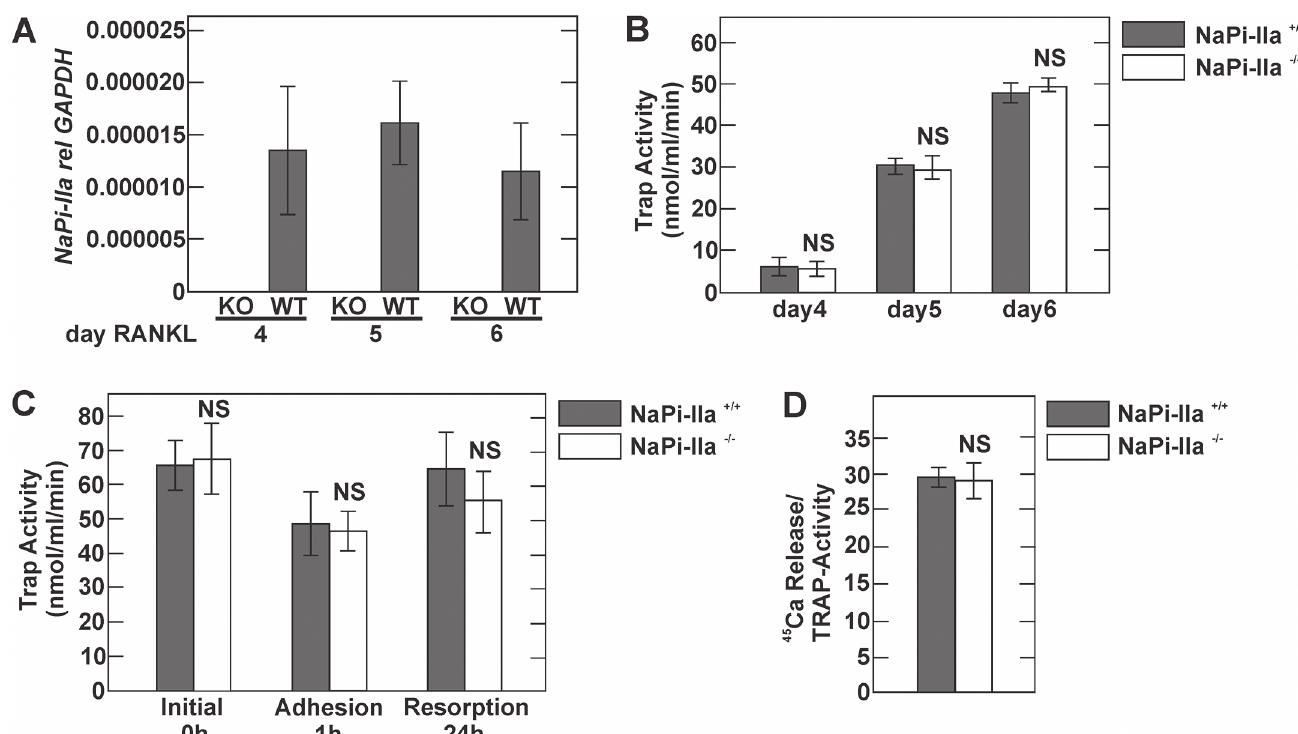
Fig 5. In vitro characterization of NaPi-IIa deficient-osteoclasts. BMMs isolated from NaPi-IIa WT and KO mice were cultured with RANKL for 4, 5 or 6 days. A) NaPi-IIa transcript expression assessed by real-time PCR analysis at days 4, 5 or 6 of RANKL stimulation. Note the absence of NaPi-IIa transcript in osteoclasts derived from NaPi-IIa KO mice. B) TRAP activity of osteoclast cultures at days 4, 5 and 6. C) TRAP activity of osteoclast cultures harvested after 0, 1 and 24h after reseeding on calcium-phosphate coated plates. D) Resorptive activity of osteoclast cultures quantified as 45 Ca content in the supernatant compared to TRAP